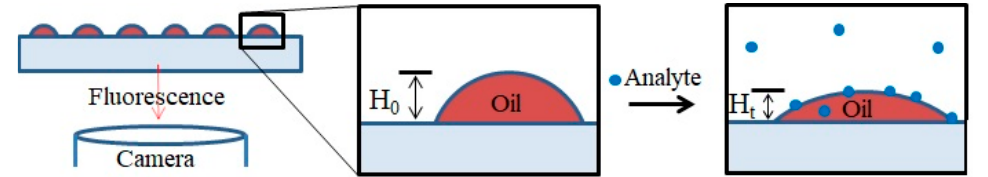
Figure 4. Schematic illustration of a lipid multilayer fluorescence assay. Fluorescently-labeled arrays of lipid droplets on a surface can be observed with a fluorescence microscope. Upon exposure to an analyte, the change in intensity or structure of the lipid arrays is monitored.